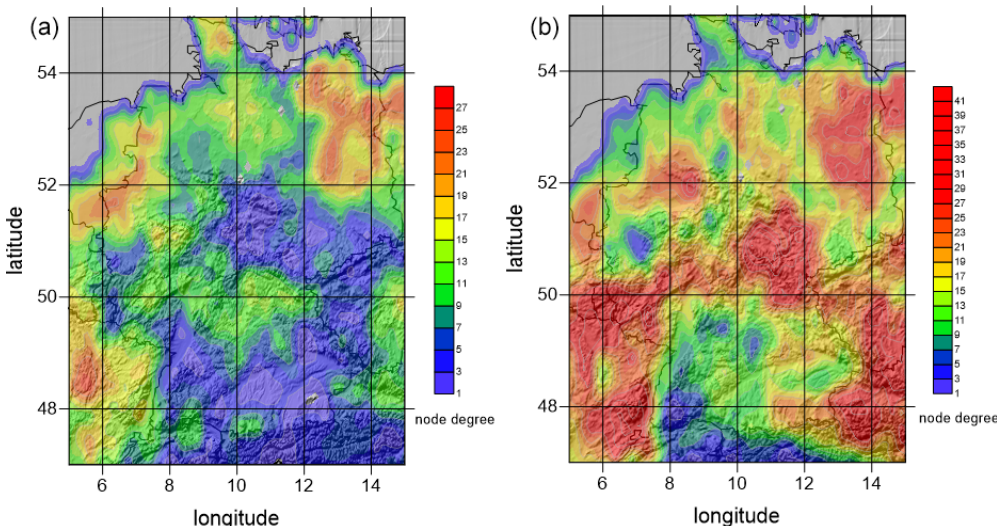
Figure 7. Comparison of the spatial distribution of the node degree between the normal year 1970 (a) and the extreme year 1976 (b) . Note the different scales.